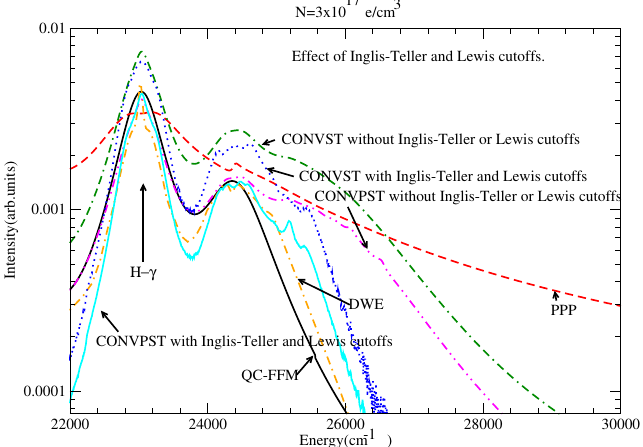
Figure 13. The series from H γ to the continuum at the lowest density. Shown are QC-FFM (solid black), PPP (dashed red), DWE (dash-dotted), CONVST without the Inglis-Teller or Lewis cutoffs (dot-double dashed green), CONVST with the Inglis-Teller and Lewis cutoffs (dotted blue) CONVPST with the Inglis-Teller and Lewis cutoffs (solid cyan) and CONVPST without the Inglis-Teller or Lewis cutoffs (magenta dash-double dotted). Strong collisions are included in all CONV